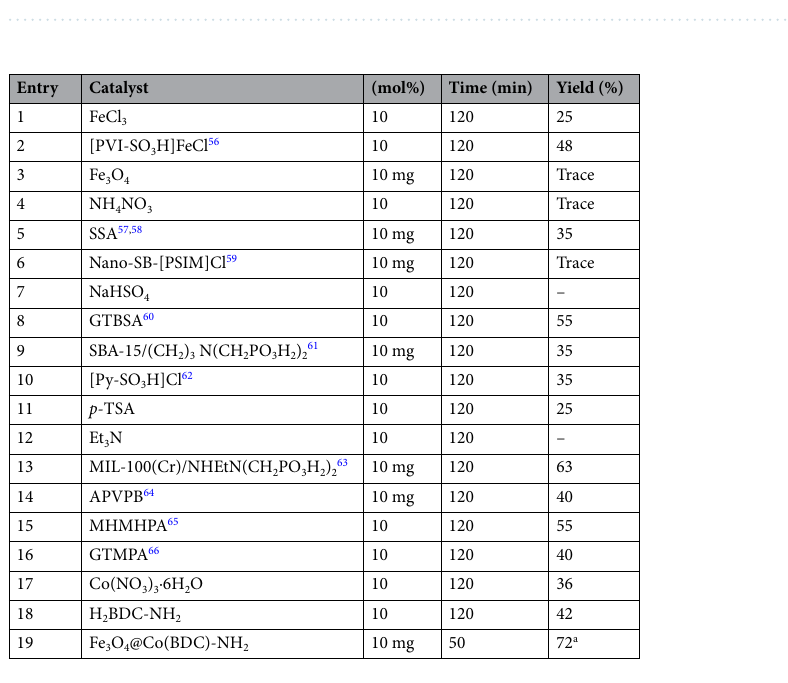
Figure 8. Recyclability of Fe 3 O 4 @Co(BDC)-NH 2 as a catalyst in the synthesis pyrazolo[4 ′ ,3 ′ :5,6]pyrido[2,3- d ] pyrimidine-5,7(6 H )-dione.